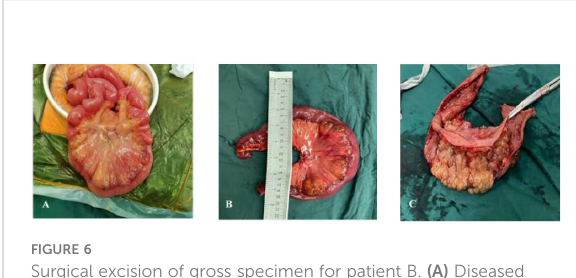
FIGURE 6 Surgical excision of gross specimen for patient B. (A) Diseased bowel piece; (B) cut a section of bowel intraoperatively, with a length of 38 cm and a diameter of 4 – 7 cm; (C) 6.5 cm from the end of one incision and 15 cm from the end of the other, a mucous vesicular uplift area of 11 cm × 7 cm can be seen. The mesentery surface is hard in texture, and the section is spongy and gray